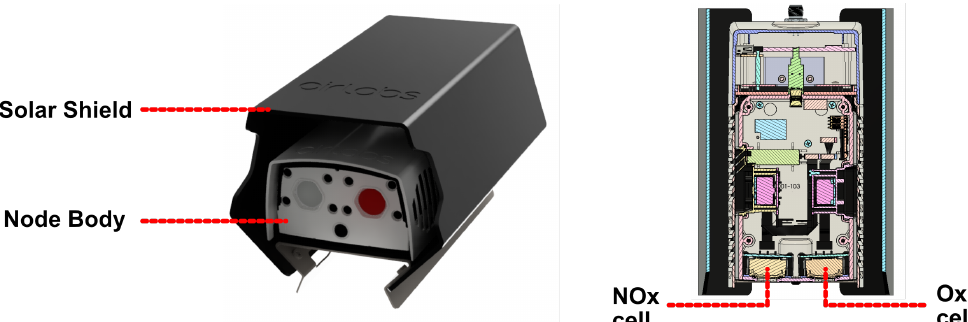
Figure 2. Gen 5 node views, node with heat-shield installed ( left ), and cross-section of the node with sensor locations ( right